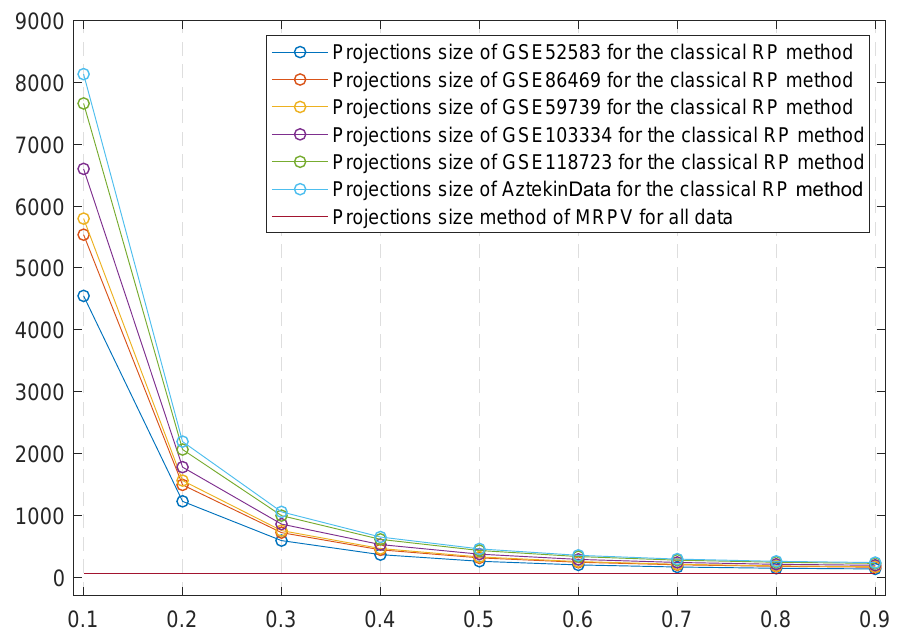
Figure 2. The relation of the appropriate dimensions size for the data projection (y-axis) and the error value ε based on the Equation (3) (x-axis), using the classical Random Projections method. The green line indicates the fixed dimensional size of the MRPV framework (50 dimensions) for all